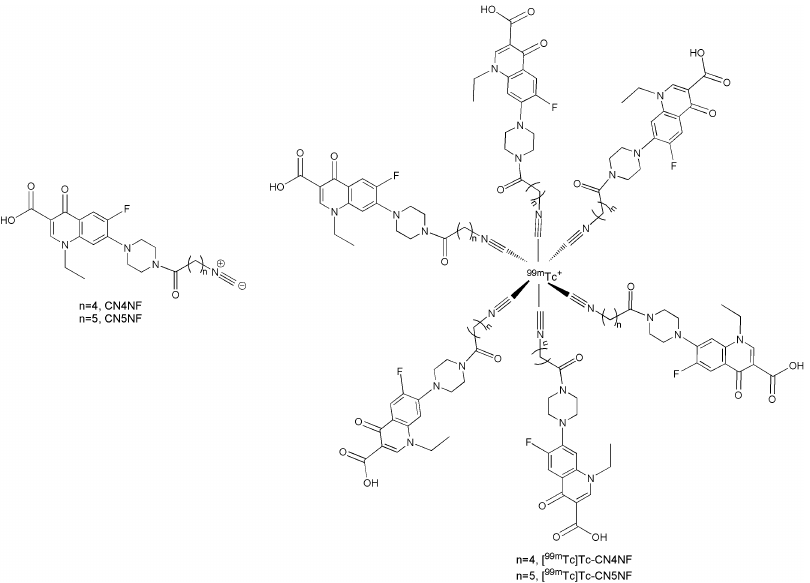
Figure 1. Structures of CNnNF ( n = 4 or 5) and [ 99m Tc]Tc-CNnNF ( n = 4 or 5).